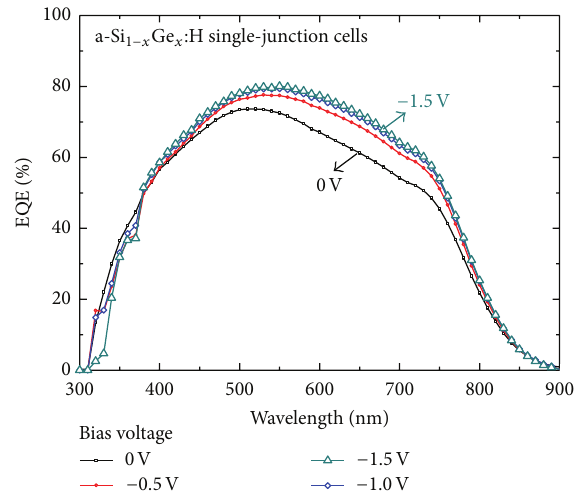
Figure1:Externalquantumefficiency(EQE)ofa-Si 1− junction cells with different reverse biases. The bias voltage was changed from 0 to − 1.5